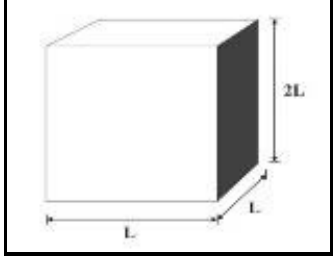
Fig. 7. Schematic Specimen for Standard Specimenof Compression Test.